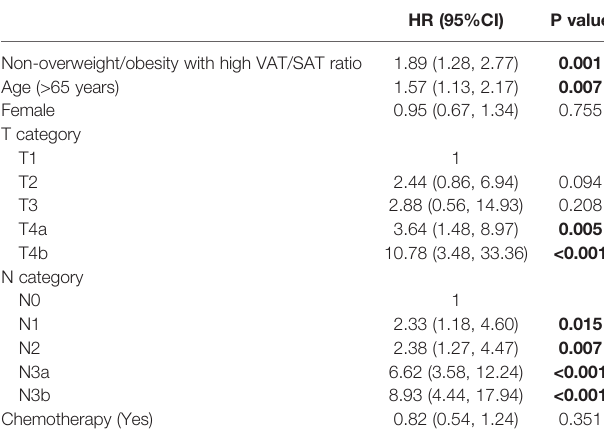
TABLE 5 | Association between non-overweight/obesity with high VAT/SAT ratio and disease-speci fi c survival by multivariate Cox analysis in patients with gastric cancer.